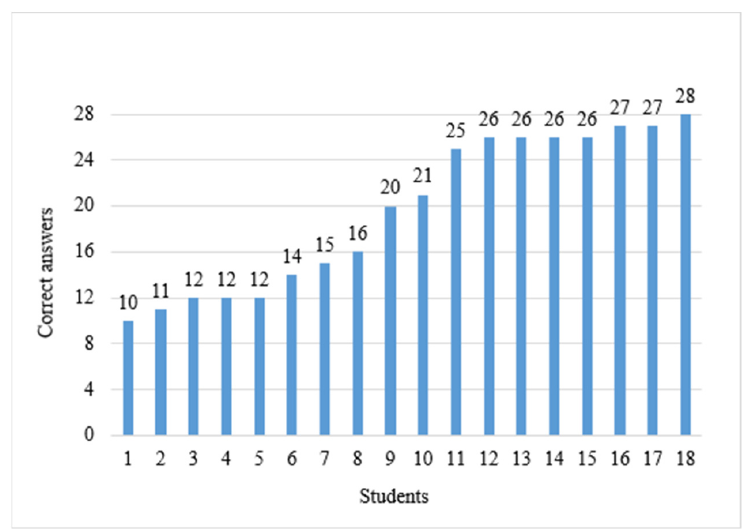
Figure 14. Fourth grade students’ performance (correct answers) in the post-test.